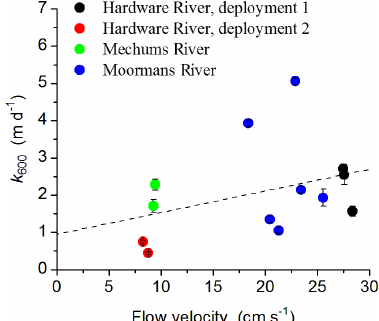
Figure 5. Standard gas exchange coefficient, k 600 , plotted against river current velocity. The dotted line is a linear fit to all data ( R = 0 . 37, p = 0 .